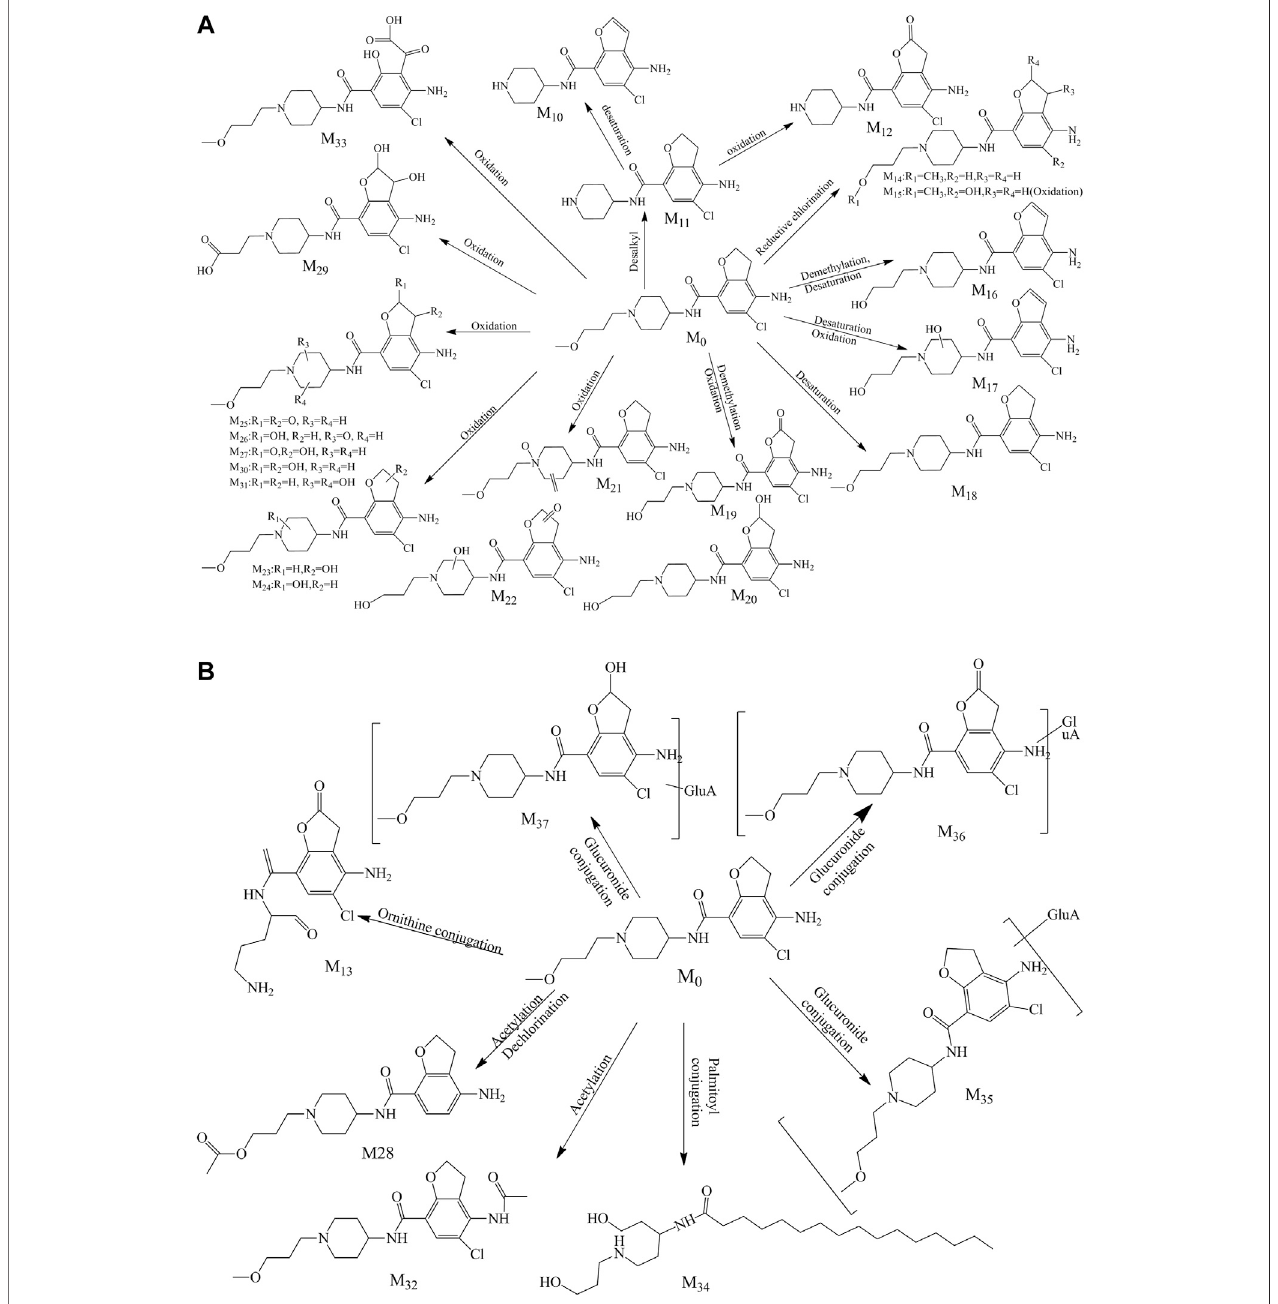
FIGURE 4 | (A) Proposed phase I metabolite pathway of prucalopride in the urine. (B) Proposed phase II metabolite pathway of prucalopride in the urine.